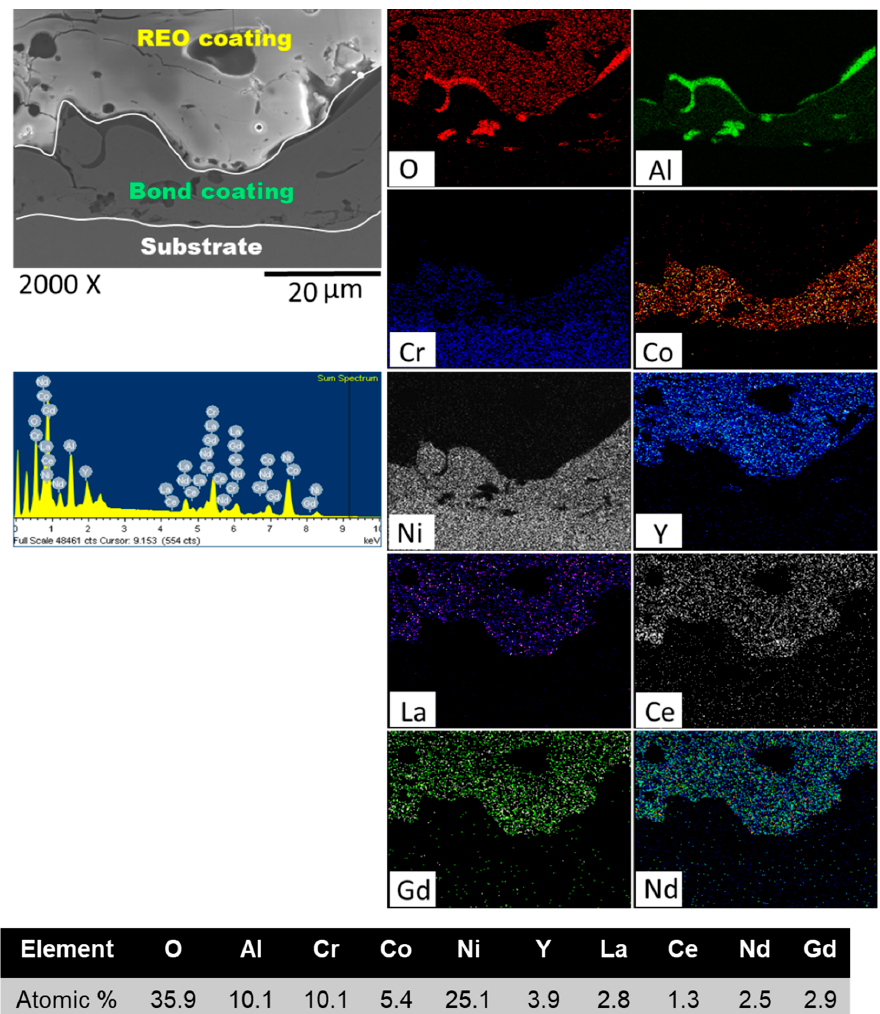
Figure 4. Elemental maps obtained from the cross-section of the REO coating.